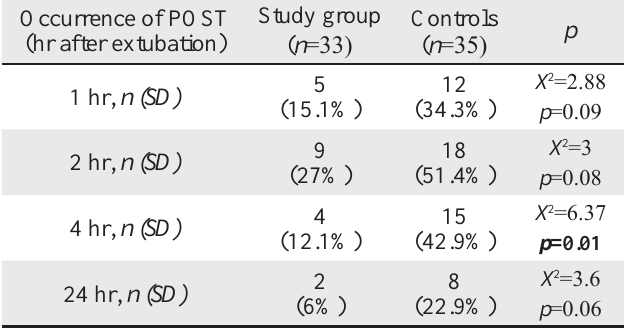
Table 3: Occurrence of sore throat at 1, 2, 4 and 24 hour post Occurrence of POST (hr after extubation)